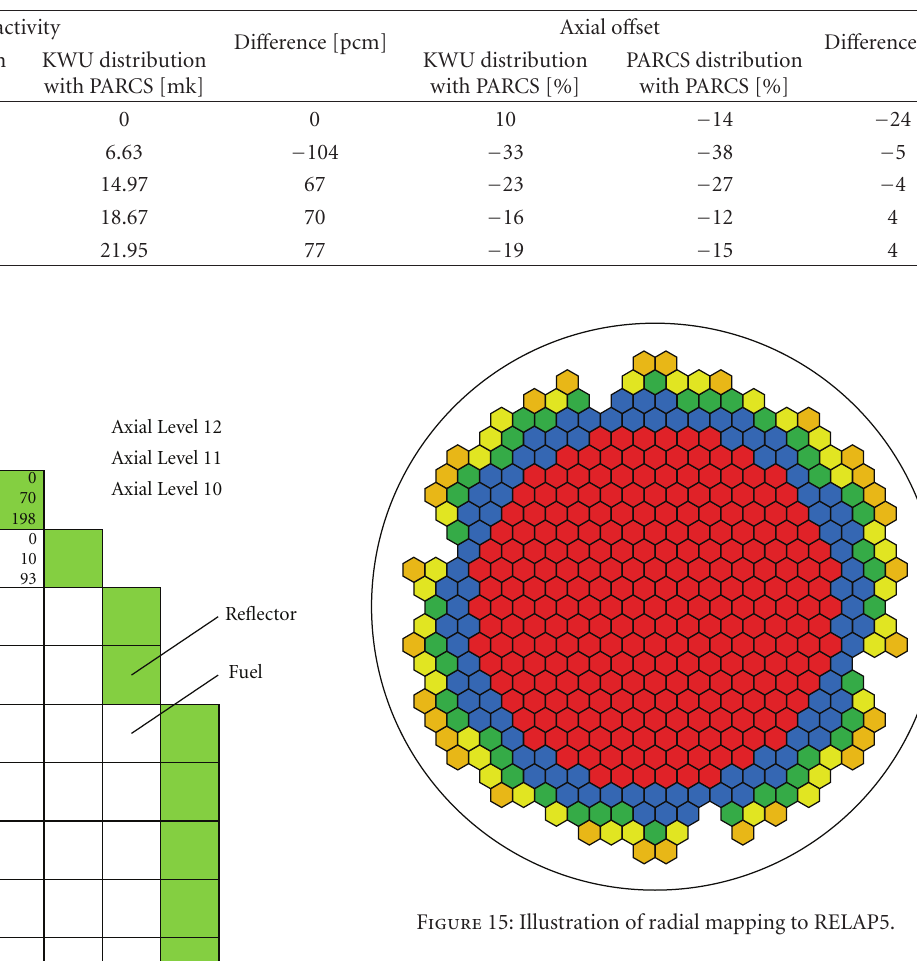
Table 15: Comparison of KWU and equation.